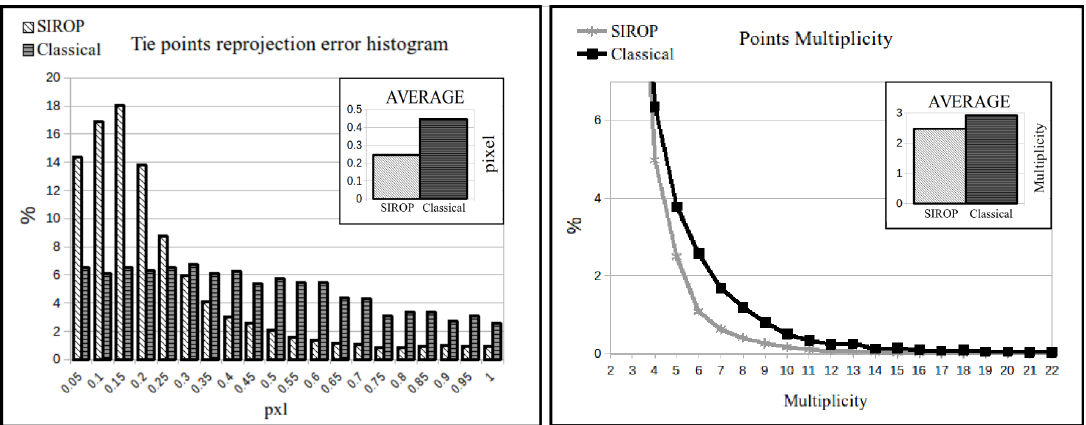
Figure 21. The scene partition and optimal resolution scene part chosen for one master image. ( Top row ): Scene partition. Each color presents the part for one master image in the dataset. ( Bottom row ): ( Right ): Demonstration for one master image (red) with its scene part and secondary images (blue). ( Left ): The scene part on master image.